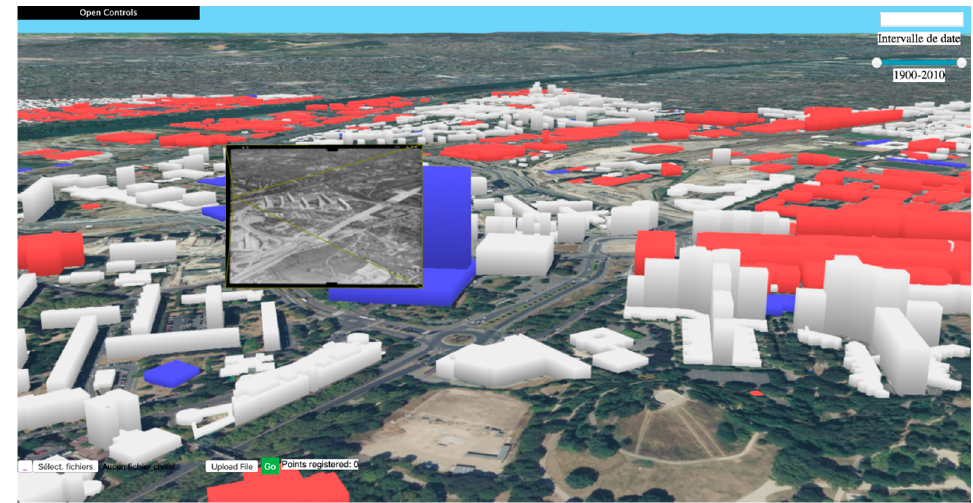
Figure 3. Free navigation in the 3D multimodal environment of Nanterre (vertical recent imagery, oblique historical imagery, statistical vector data and 3D buildings) (image from [9]).